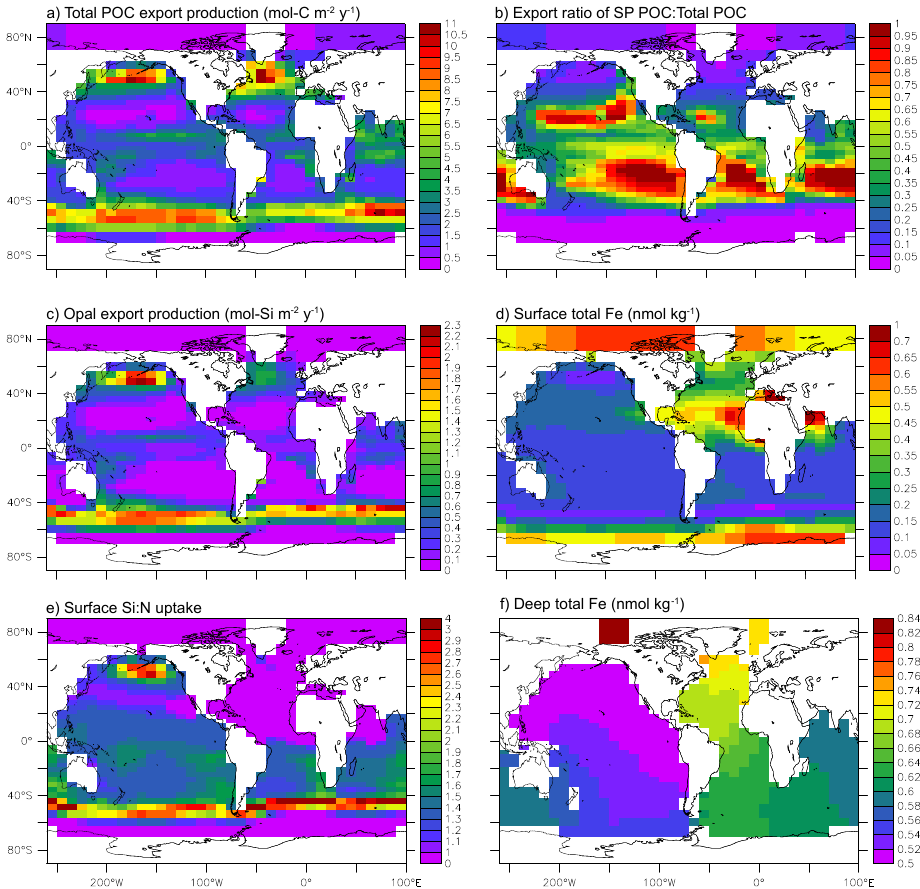
Fig. 7. Simulated annual mean results from MESMO 2: (a) POC export production; (b) fractional contribution of the small phytoplankton to the total POC export production; (c) opal export production; (d) surface FeT concentration; (e) Si : N uptake ratio by diatoms; (f) mean FeT in